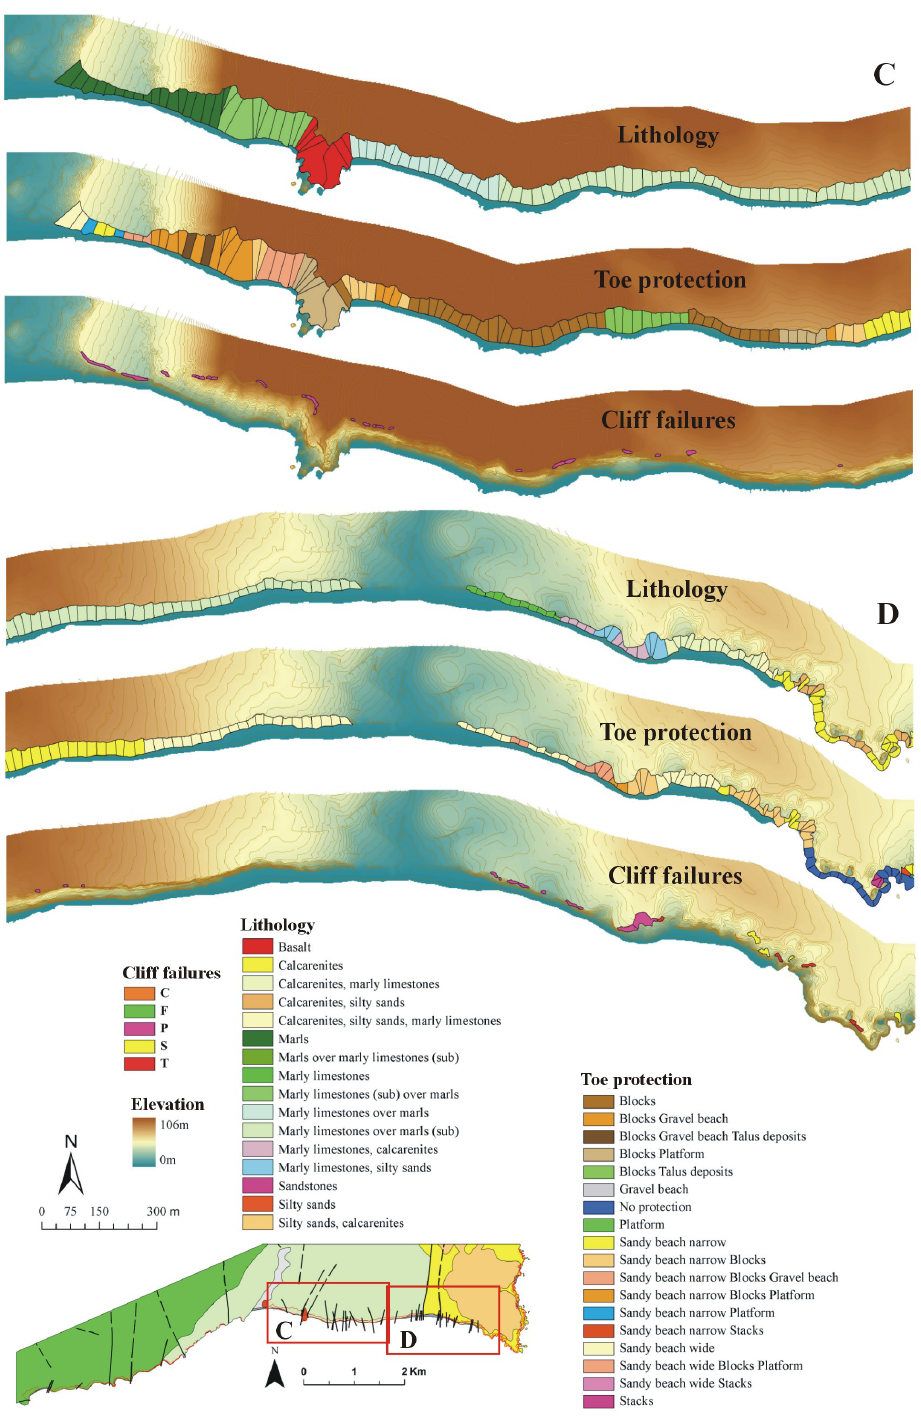
Fig. 6b. Lithology, toe protection and cliff failures in sections C and D. Lithology and toe protection mapped according to the terrain units used in this study. Cliff failure areas are not to scale to enable visualization. Cliff failures legend: C – Complex and not determined; F – Rockfalls; P – Planar failures; S – Slumps; T – Toppling failures. Contour line interval is 2m.